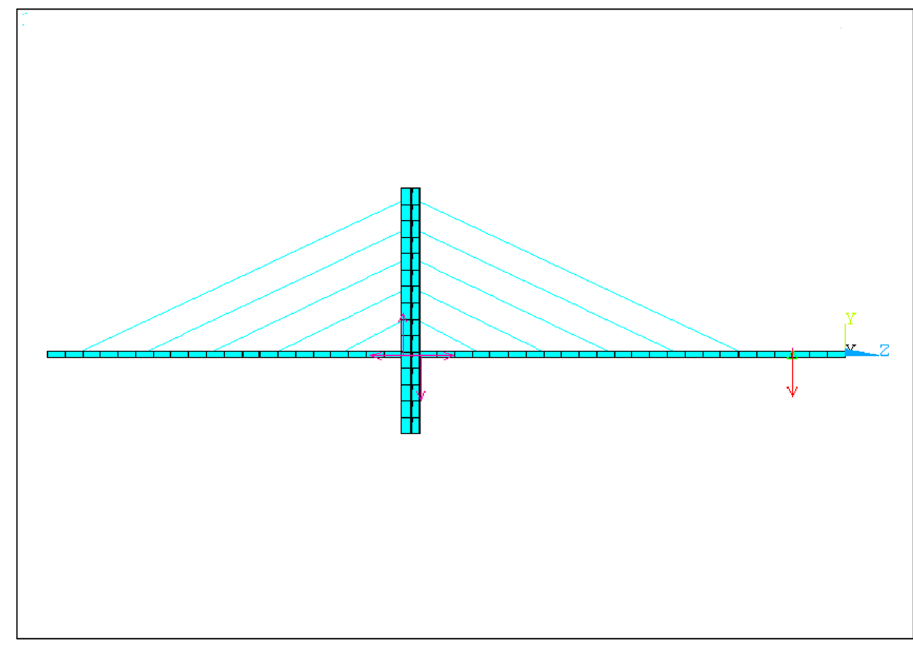
Figure 6: Coupling technique for making a group of nodes.